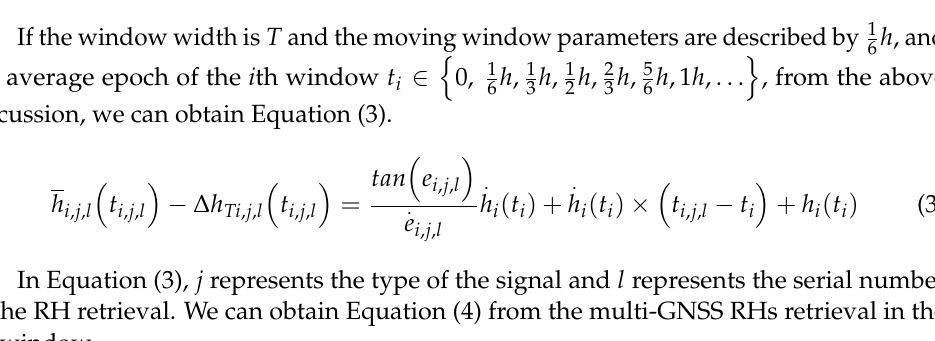
Figure 2. Number of RH points in each window: ( a ) for the BRST station, the number of RH points in each window during DOY 177–191, 2021; ( b ) for the HKQT station, the number of RH points in each window during DOY 177–191, 2021.